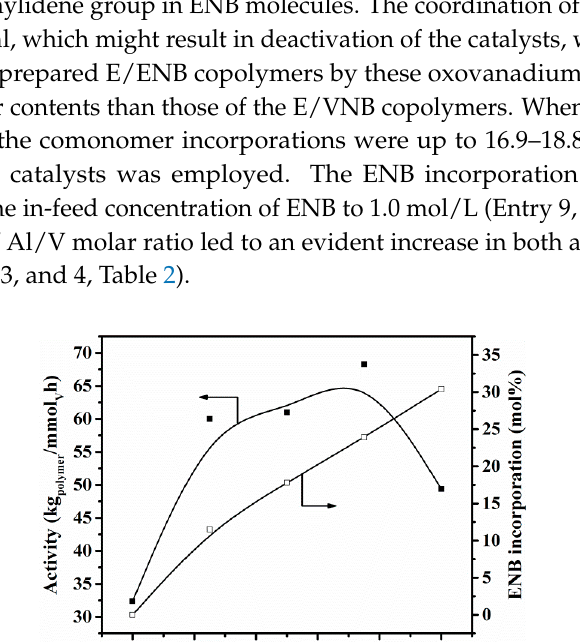
Table 2. Ethylene/ENB copolymerization by oxovanadium(V) complexes.